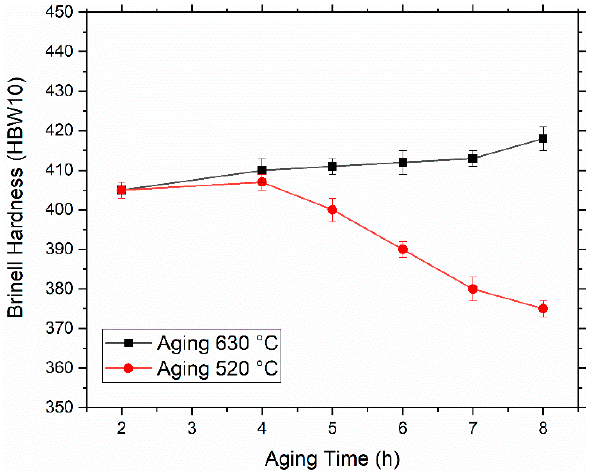
Figure 11. Hardness assessment after second aging at two different temperatures.